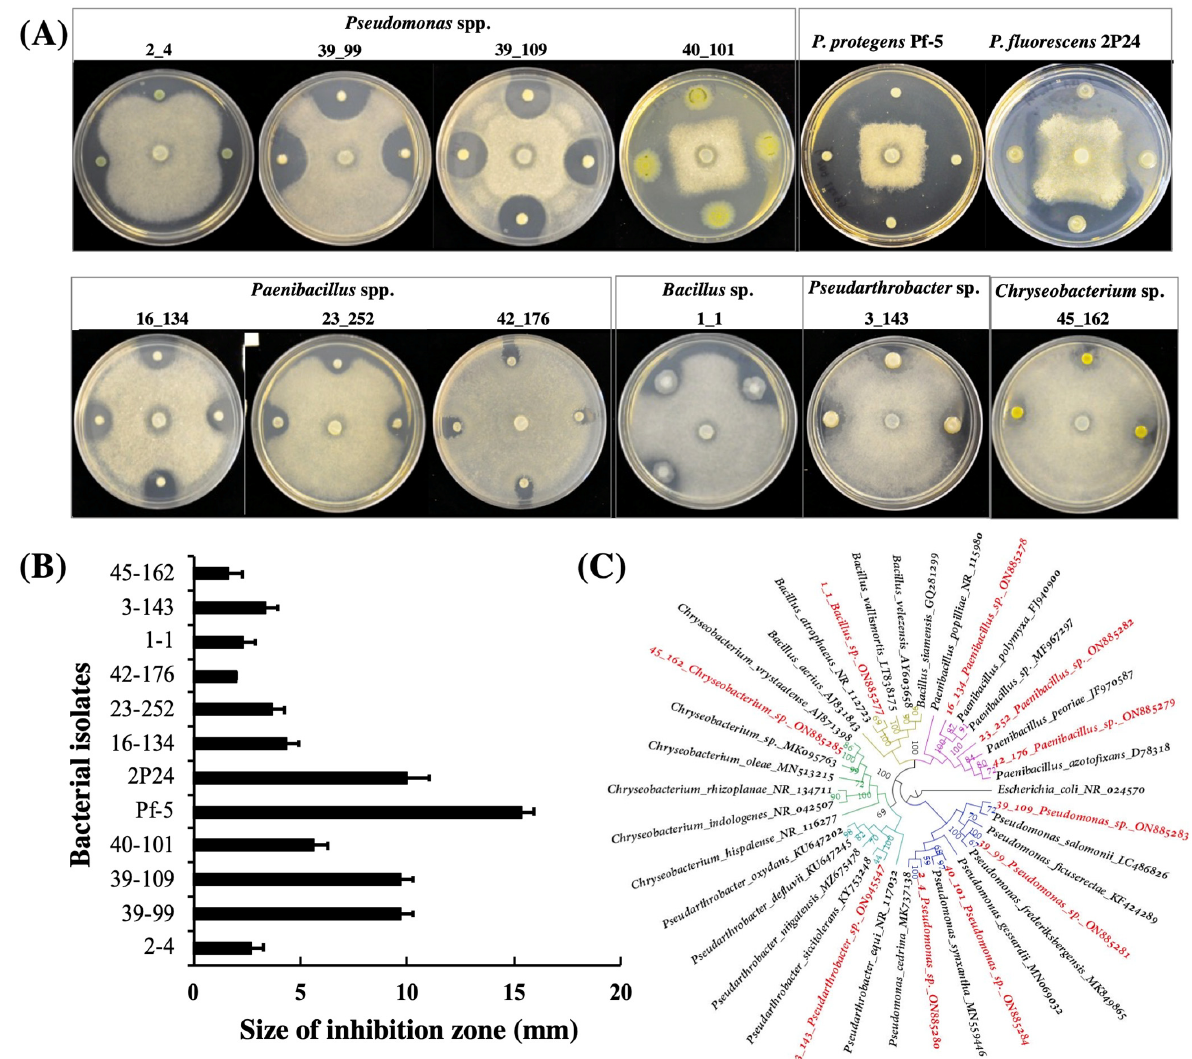
Figure 1. Bacterial antagonists inhibit the growth of A. euteiches . A. euteiches was cultured in the center of the plates and the bacterial cells were inoculated around the pathogen. All strains were cultured on ½ PDA plates at 28 ° C for three days before the results of the inhibition were recorded ( A ) and the size of the inhibition zone was measured ( B ). The experiment was repeated three times with similar results. ( C ); the taxonomy of the bacterial antagonists that were isolated in this work was identified by 16S rRNA analysis. The phylogenetic tree was constructed using IQ-tree and visualized using Figtree v 1.4.4. Five different bacterial genera forming distinct clades are represented by different colors at the branches. The ten bacterial isolates highlighted with red color were isolated in this study. The GenBank accession number of each isolate was shown. The values at the node of the tree represent bootstrap support.